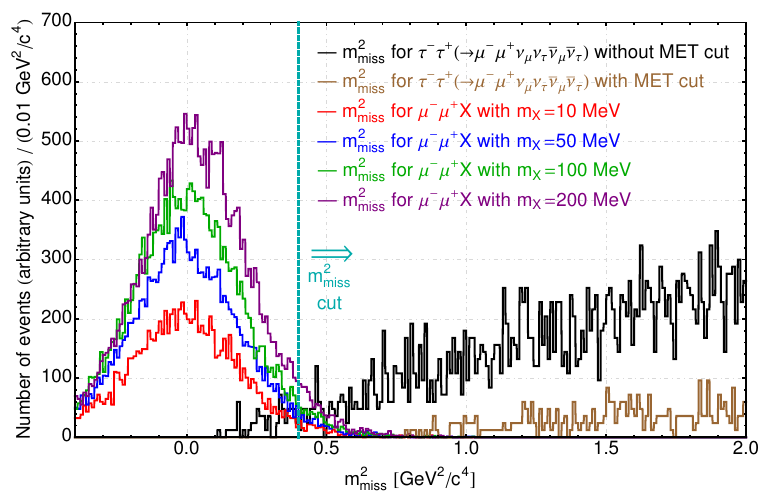
Figure 7 . m 2 distribution for muonically decaying (cid:28) (cid:0) (cid:28) + background (with and without missing miss transverse energy cut =E > 1 : 67 GeV) and (cid:22) (cid:0) (cid:22) + X signal events. All signal events are obtained T after =E cut. We only choose events with m 2 < 0 : 4 GeV 2 =c 4 . The missing-mass-squared cut is T miss shown as vertical dotted